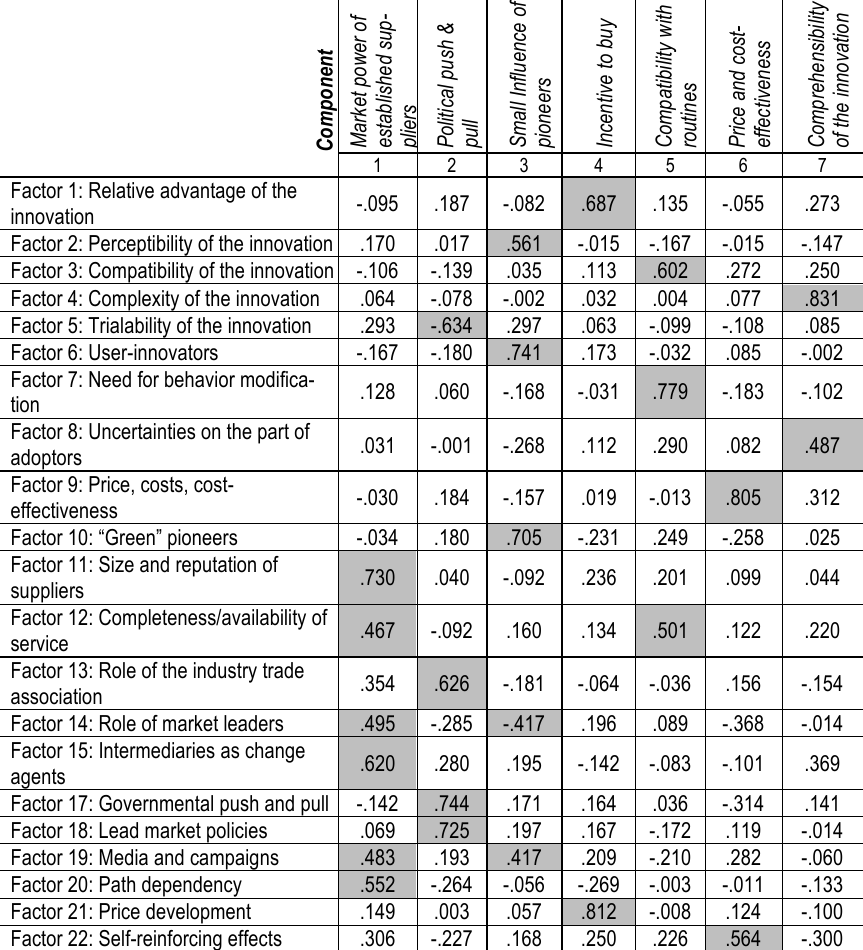
Table 4. Factor analysis: Rotated component matrix